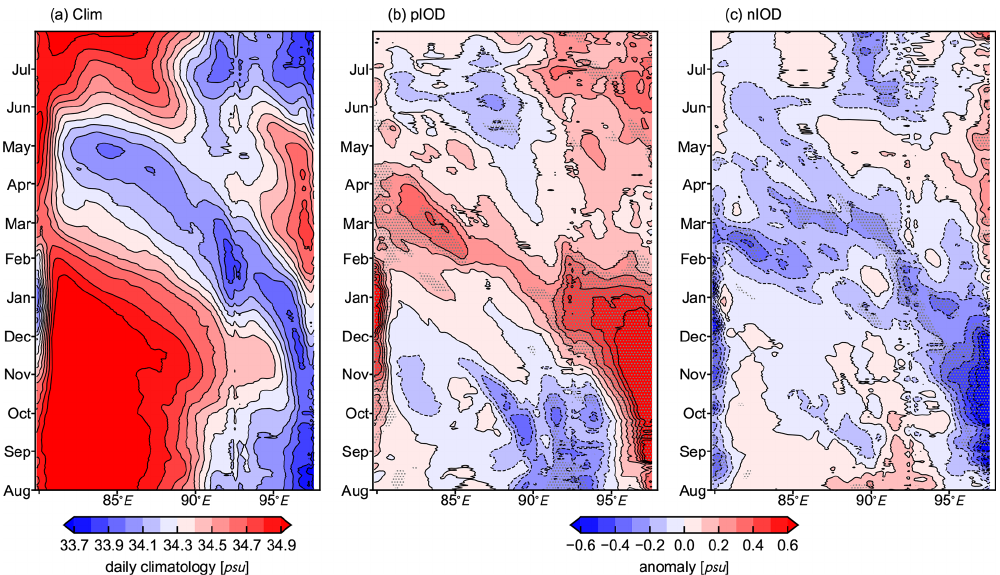
Figure 13. Hovmöller diagram of daily climatological subsurface (100m) salinity ( a ; averaged over 10 to 12 ◦ N) from HAMSOM. The intervals are 0.1psu. Panels (b) and (c) are the same as (a) but for the composite of subsurface salinity anomalies for pIOD (b) and nIOD (c) , respectively. The intervals are also 0.1psu. Anomalies significant at the 95% confidence level by a two-tailed Welch’s t test are hatched with grey